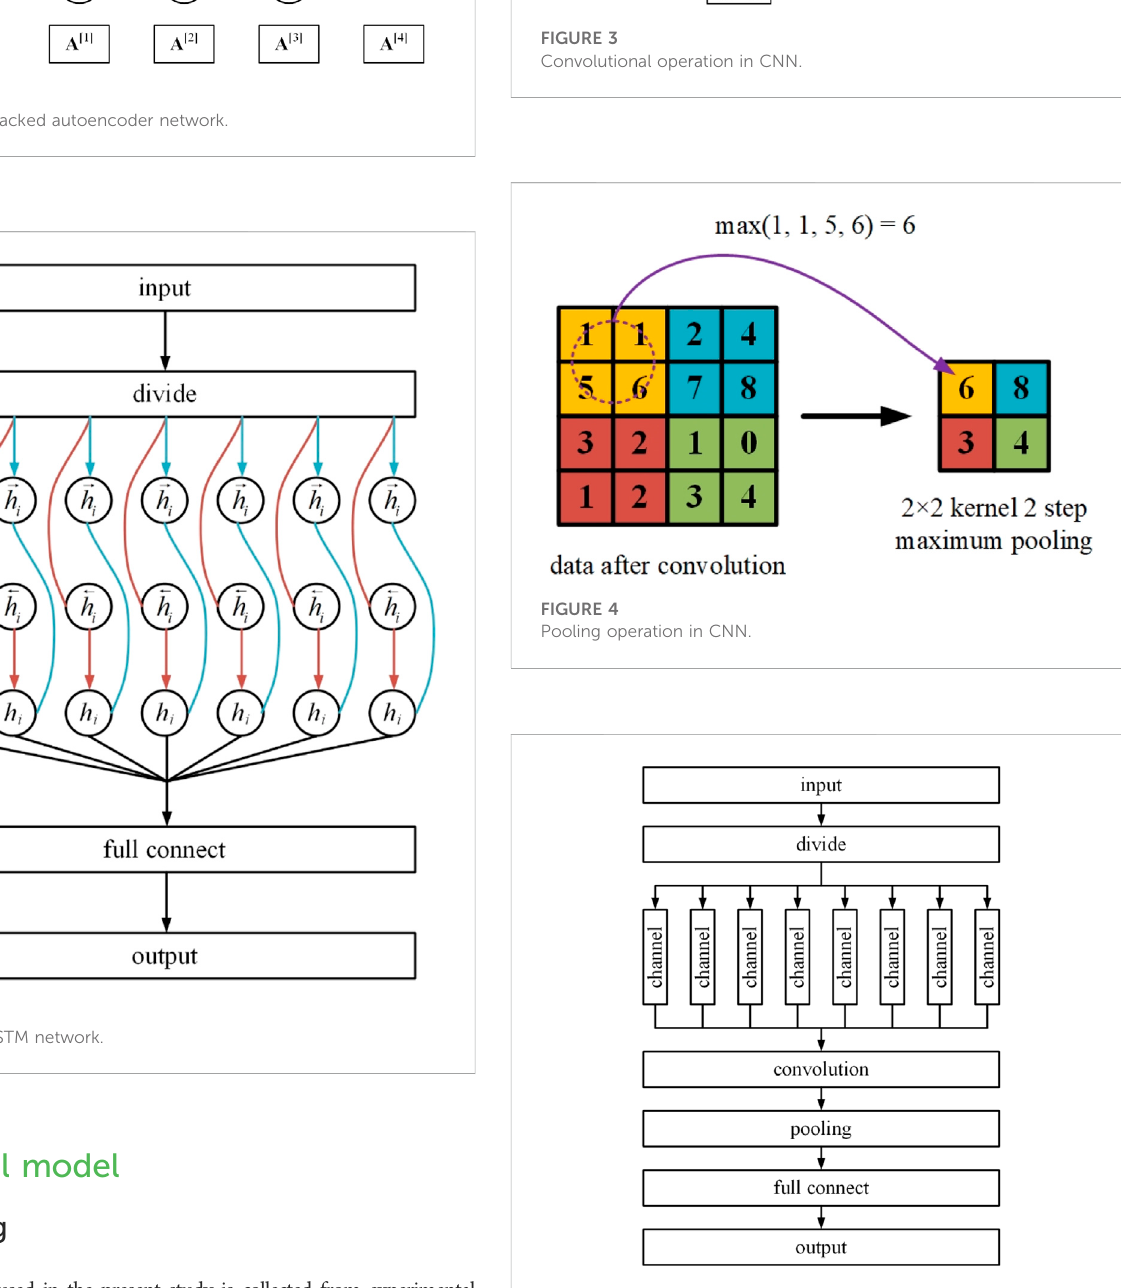
FIGURE 5 Structure of convolutional neural